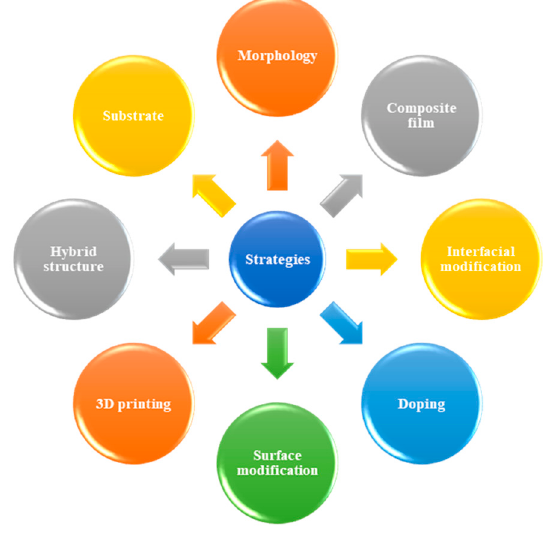
Figure 2. Different strategies used to improve the performance of PENGs.